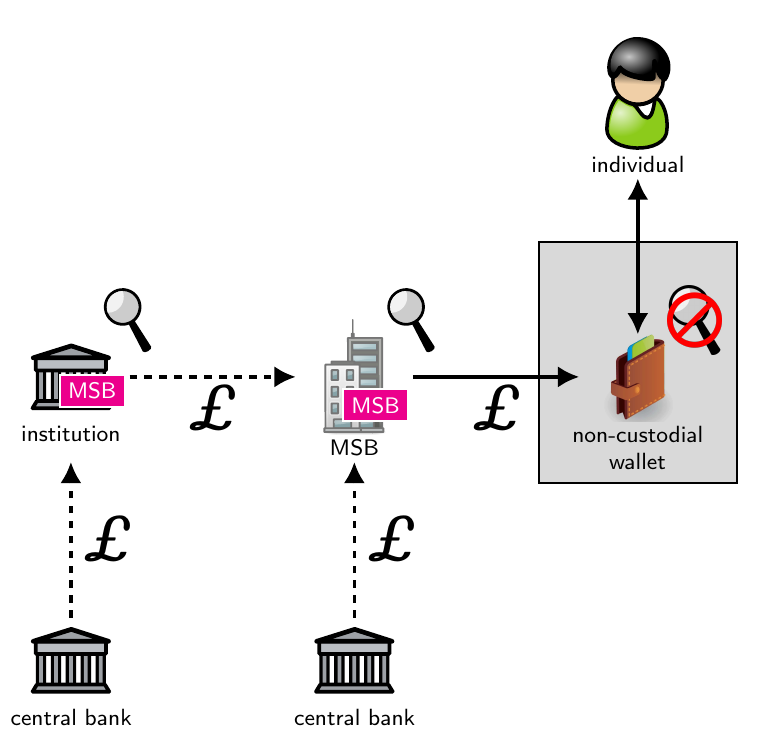
Figure 6. Schematic representation of a disbursement to a retail user with a non-custodial